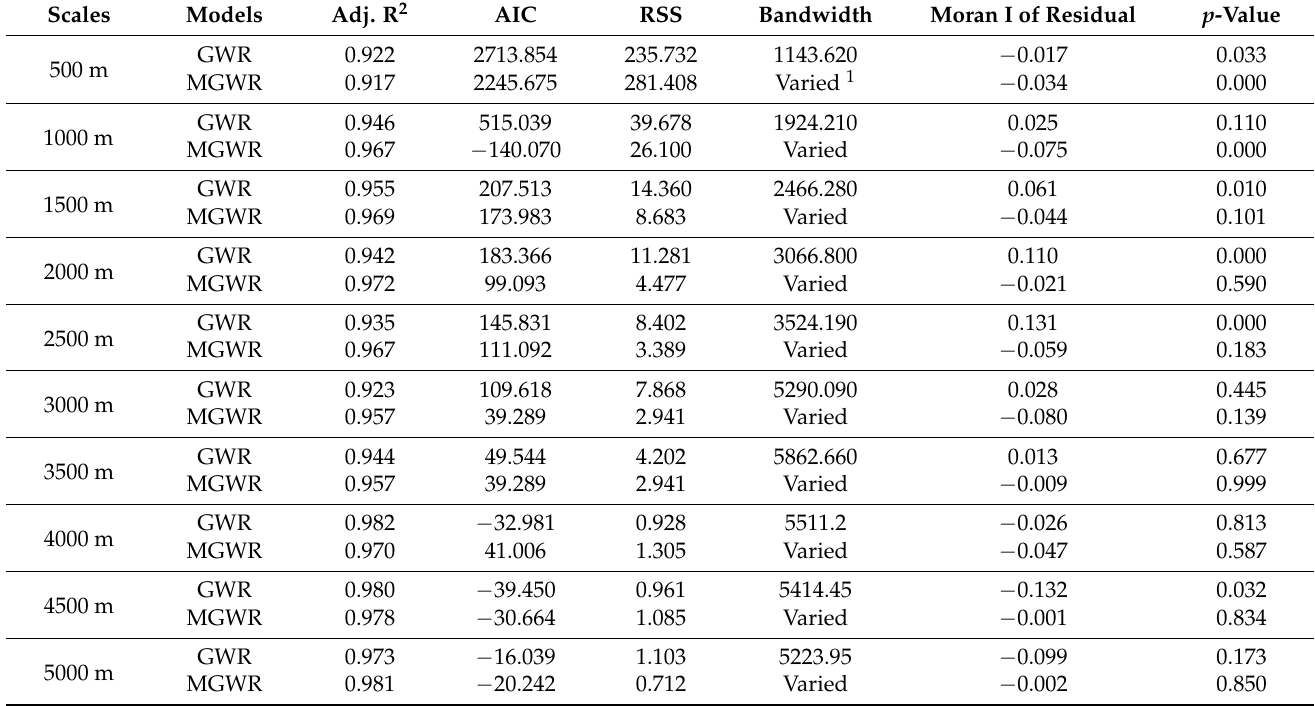
Table 5. Model evaluation results of local models in different